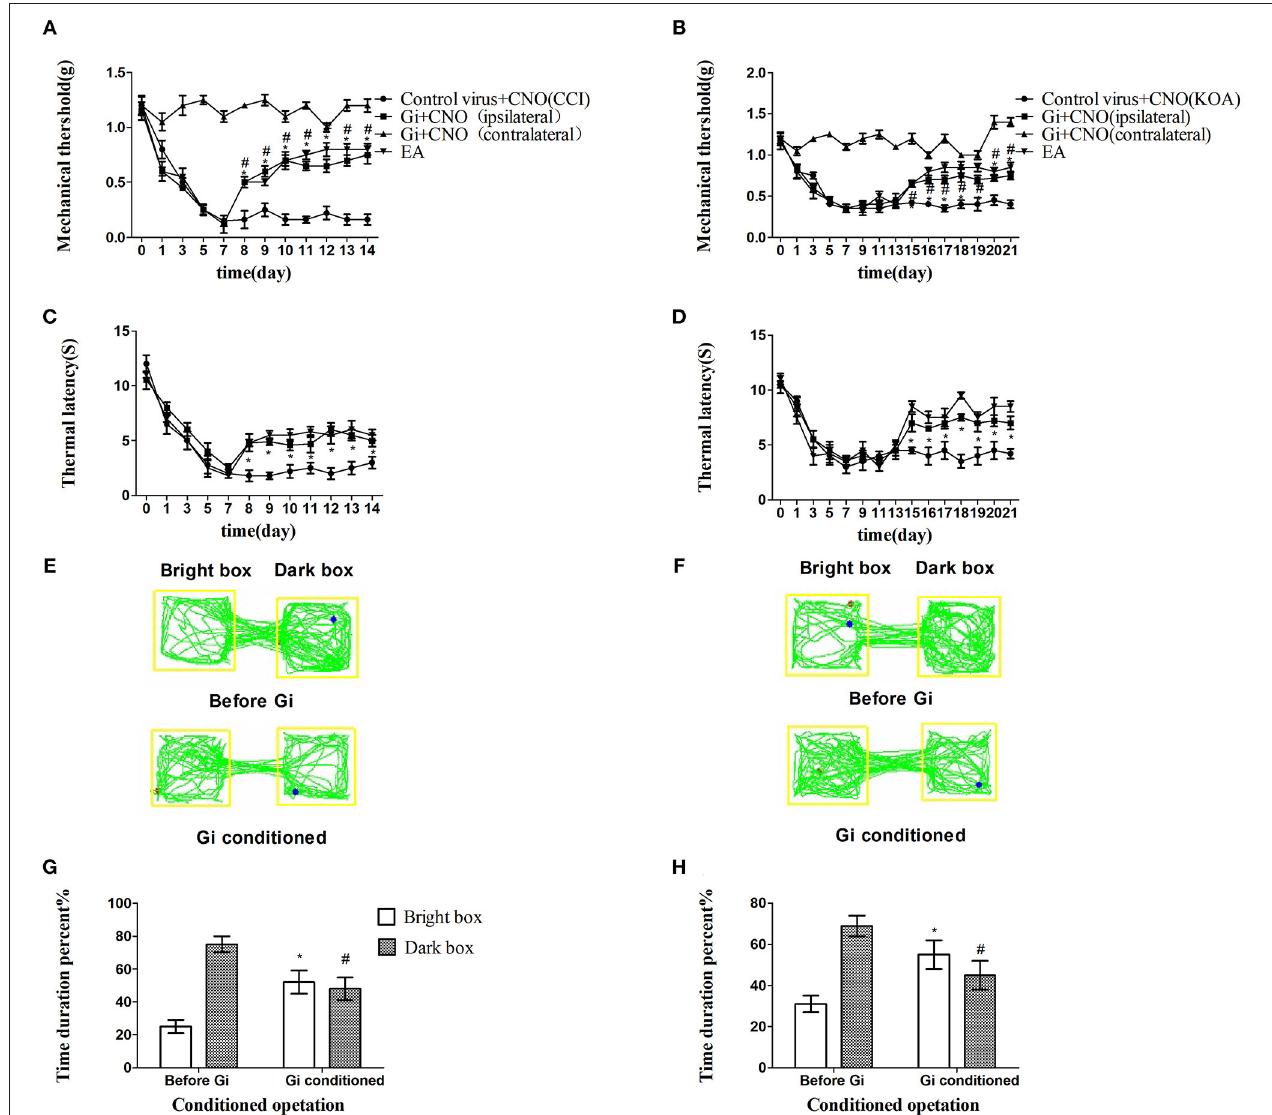
FIGURE 3 | Chemogenetic inhibition of GABAergic neurons in the vlPAG replicated the effects of EA. (A,B) Time course of tactile threshold in response to von Frey filaments. (C,D) The noxious heat stimulus (53 ◦ C) caused a change in the thermal thresholds. Tactile (A) and thermal (C) withdrawal thresholds changes in CCI mice after chemogenetic inhibition. Changes in tactile (B) and thermal (D) withdrawal thresholds of KOA mice caused by chemogenetic inhibition. Motion map of chemogenetic inhibition of conditioning in the CPP test with CCI (E) and KOA mice (F) . G,H are summary values of motion trajectories. Virus was injected 21 days before the behavior test. CNO (1 mg/kg) was administered once a day starting from the 8th to the 14th day in the CCI model and starting from the 15th to the 21st day in the KOA model. EA (1mA and 0.1ms) at 2Hz was administered for 30min. Once a day starting from the 8th to the 14th day in the CCI model and starting from the 15th to the 21st day in the KOA model, all behavior tests were completed 2h after CNO administration. Control groups consisted of CCI or KOA mice injected with control virus and CNO but without EA treatment. Data are expressed as means ± SEM ( n = 12 in each group). In A–D , * p < 0.05, compared with control group; # p < 0.05, compared with the model group; in G,H ,* p < 0.05, compared with the bright box time duration percent before chemogenetic inhibition; # p < 0.05, compared with the dark box time duration percent before chemogenetic